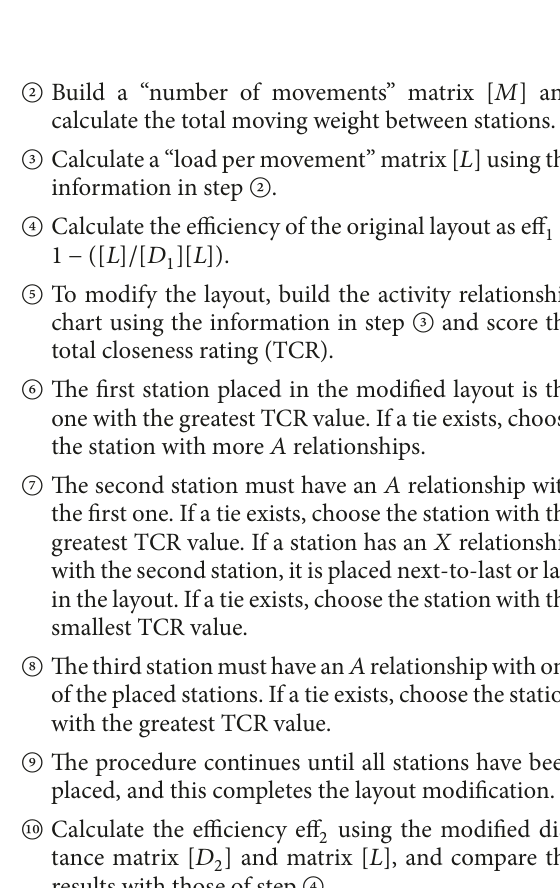
Figure 3: Transportation system of the entire facility. The transportation systems covered by this study are the gantry crane GC2.V1 and the robotic crane RC21.V1 in the oxide reduction process cell.